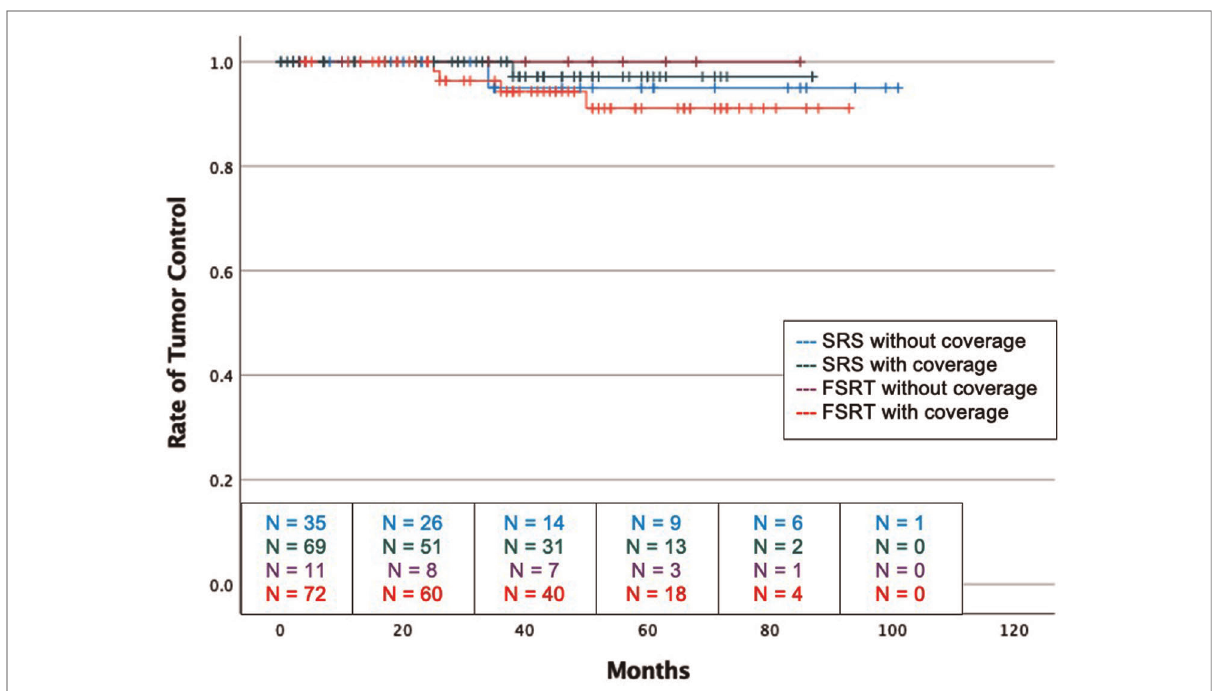
FIGURE 3 Kaplan-Meier graph demonstrating rate of tumor control amongst the four groups. Blue: SRS without dural tail coverage, Green: SRS with dural tail coverage, Purple: FSRT without dural tail coverage, Red: FSRT with dural tail coverage. Dashes indicate censored patients due loss of follow-up or death. Number of patients remaining without recurrence or loss to follow-up is provided along the x-axis at 20-month intervals (Log Rank P